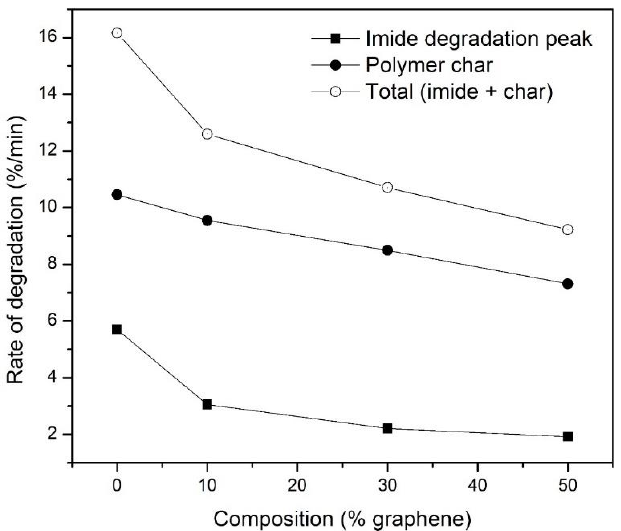
Figure 4. Rate of degradation of imide peak and polyimide char of neat PI and PINGS composites .